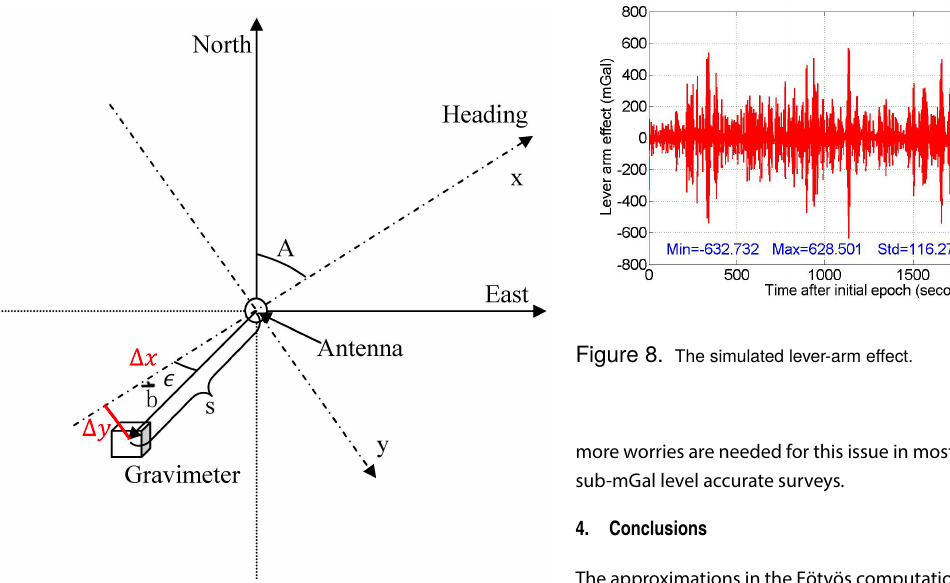
Figure 4. The approximation errors by neglecting the higher order terms (units are 1/m) in the coefficients of V 2 N and V 2 E in Eq. (1) along the simulated flights.